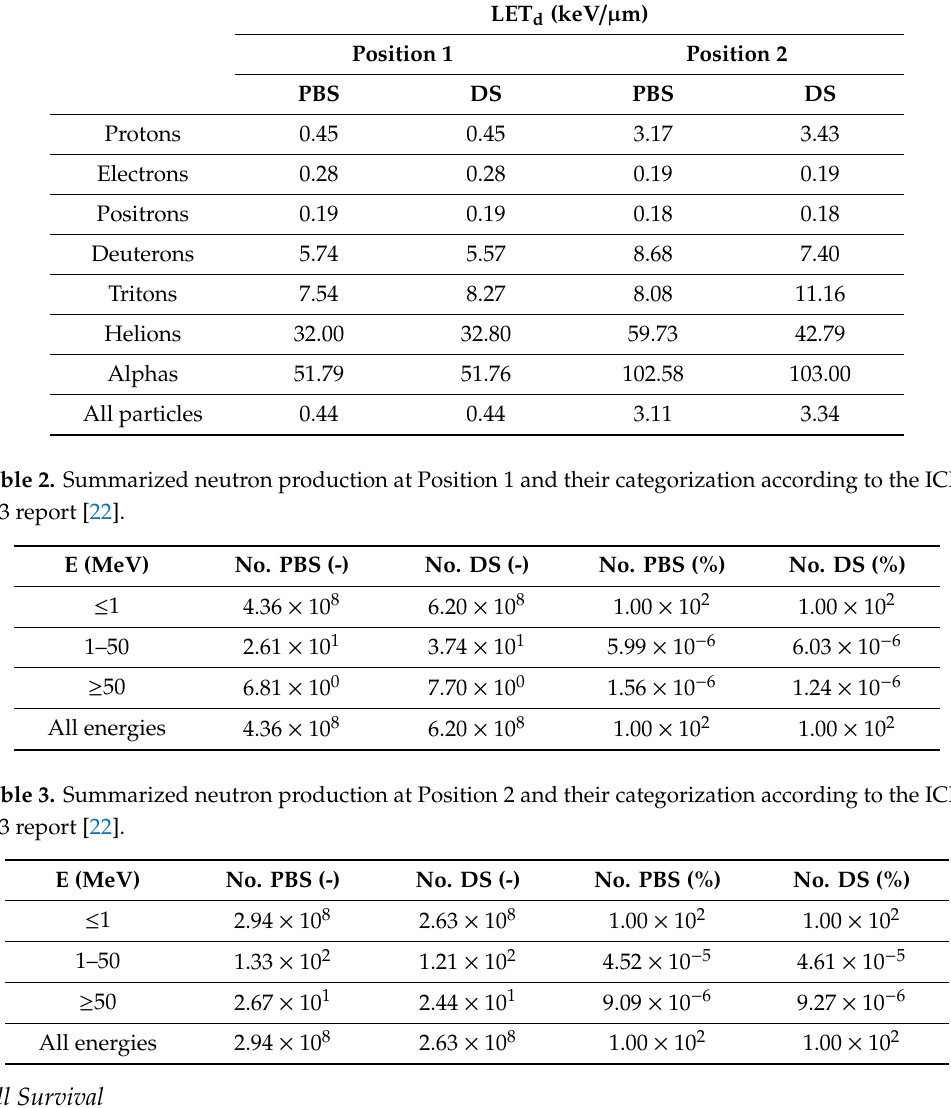
Table1. Thedose-averagedlinearenergytransfer(LETd)valuesforthetwomodesandthetwopositions.